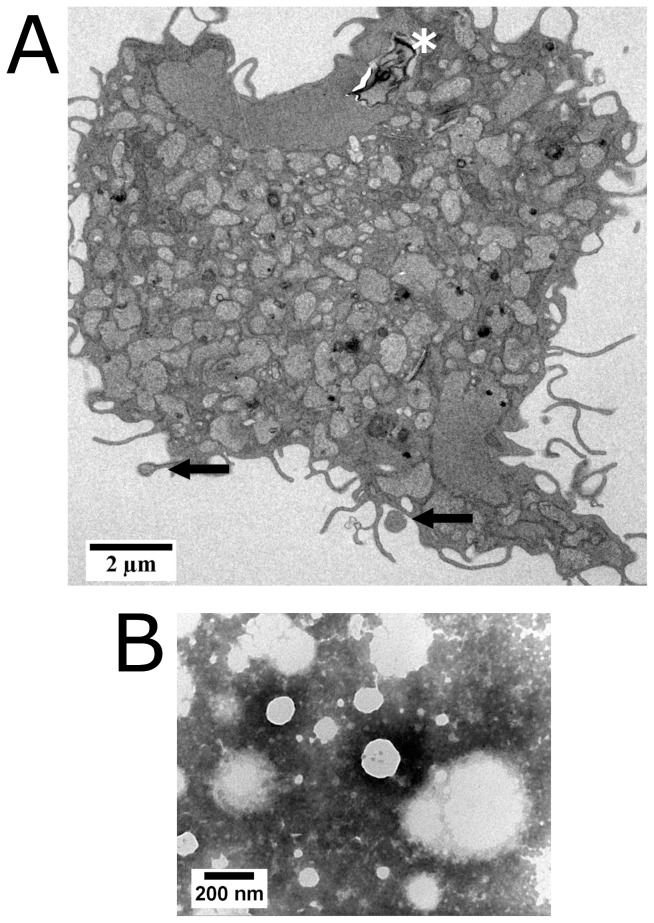
Transmission electron microscopy of extracellular vesicles (EVs) from supernatants of infected macrophage cultures and of L. amazonensis-infected macrophages presenting budding EVs.A, a macrophage was fixed with 2.5% glutaraldehyde and 2% paraformaldehyde and post-fixed with 1% osmium tetroxide, 0.8% potassium ferricyanide and 5 mM calcium chloride. The arrows indicate EVs being formed; the dark asterisk at the top of the figure indicates the position of the remainings of a Leishmania amastigote. Scale bar = 2 µm. B, EVs were adsorbed to copper grids (Formvar) for 20 minutes and negatively stained with 2% phosphotungstenic acid. Scale bar = 200 nm.